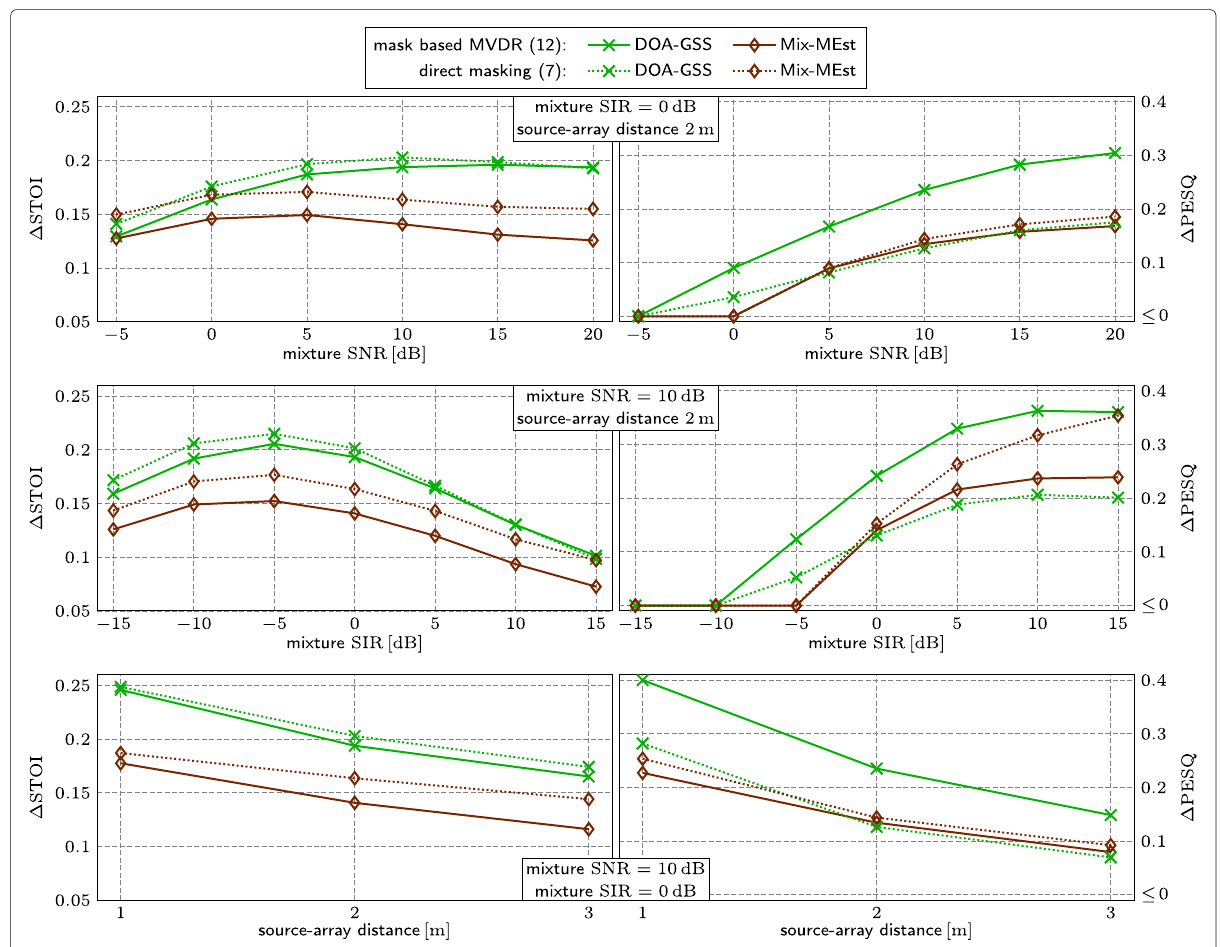
Fig. 13 Performance of the DOA-GSS and the neural network-based Mix-MEst approach of [6] as a function of the mixture SNR (top), SIR (middle), and the source-array distance (bottom). For the DOA-GSS, the DOA-based initialization and the DTAs are used, but the STAs are omitted